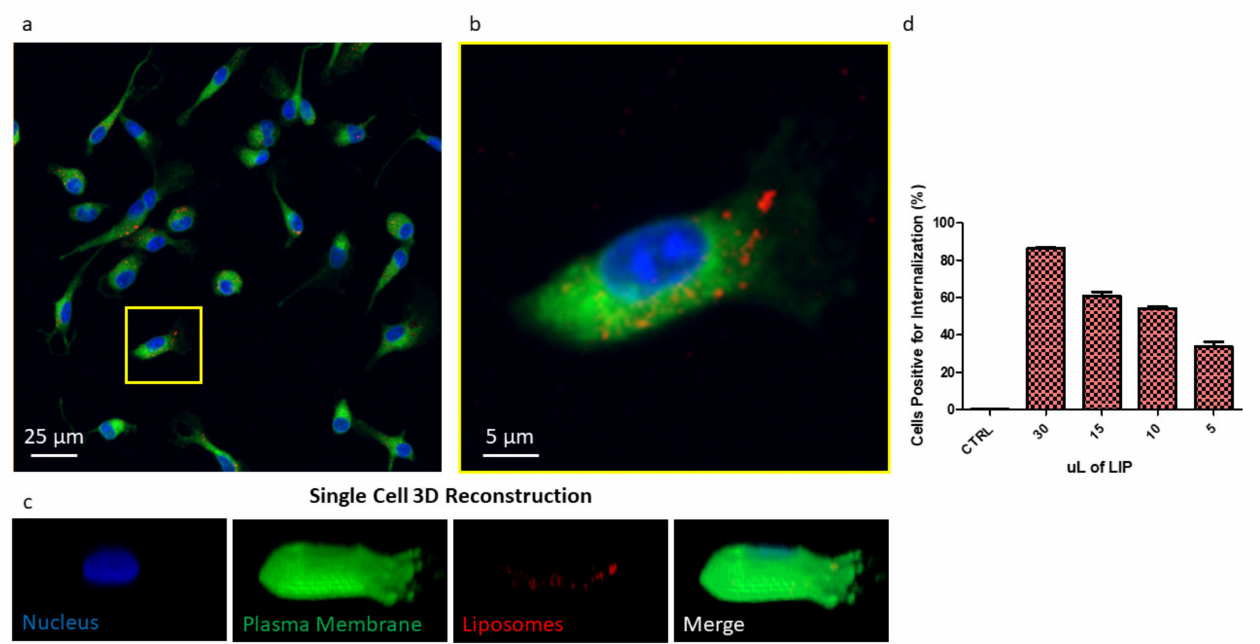
Figure 5. ( a ) Image reporting a maximum intensity profile of a z-stack of BMDMs treated with liposome reporting in blue the nuclei, in green the plasma membrane and in red the liposomes. ( b ) Higher magnification inset of a single cell. ( c ) Single cell 3D reconstruction with split channels and merge. ( d ) Flow cytometry analysis of BMDM uptaking